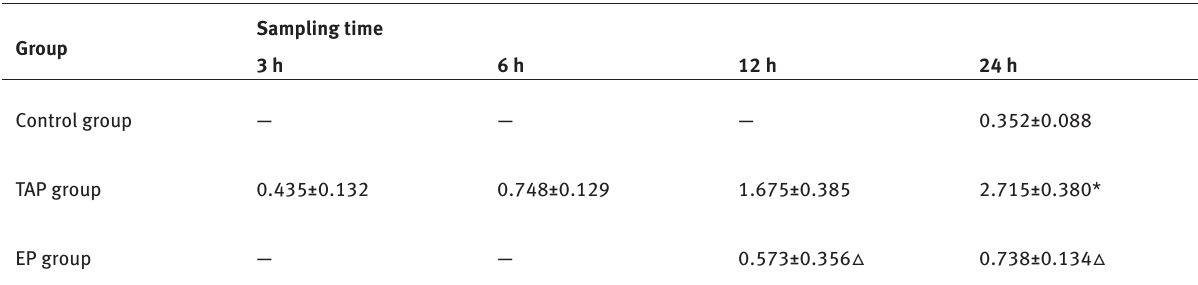
Table 2: Relative protein expression levels of HMGB1 in pancreatic acinar cells from the different rat groups at various time points ( x ±s , n =4 per treatment group) Group